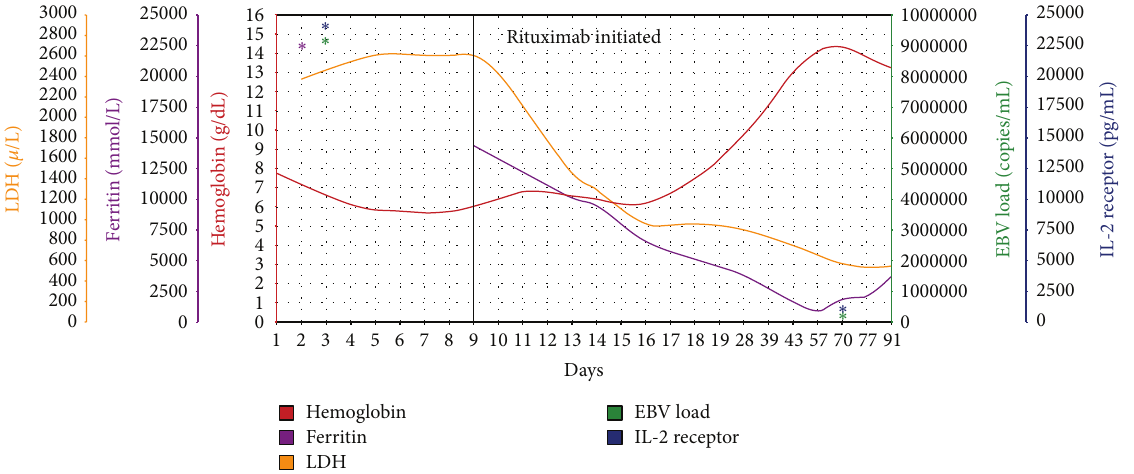
Figure 2: Trend of hemoglobin and markers of disease severity before and after starting rituximab.